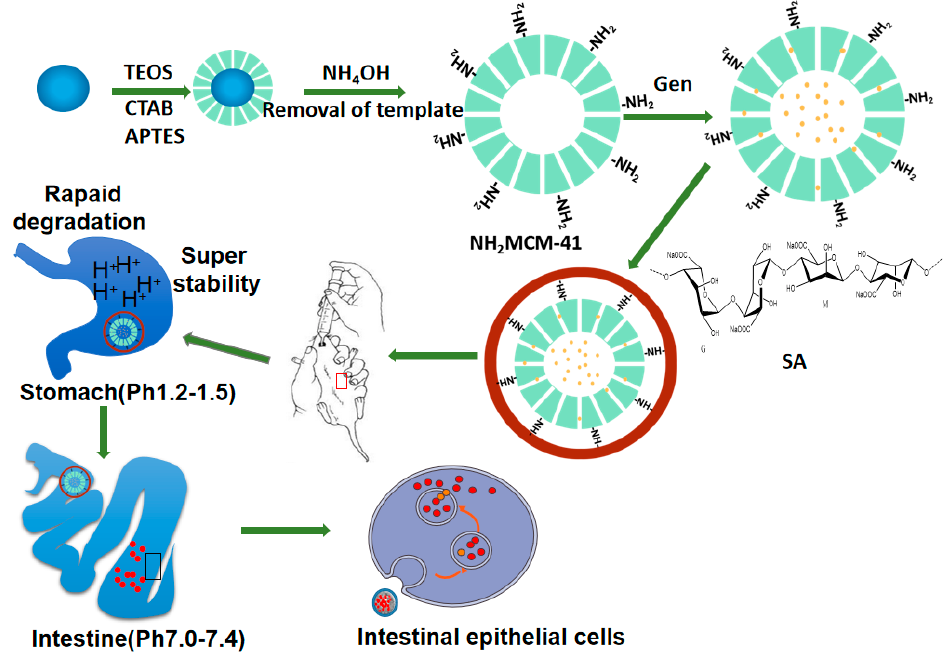
Figure 4. The synthesis process of NH 2 -MCM-41@SA nanoparticles.